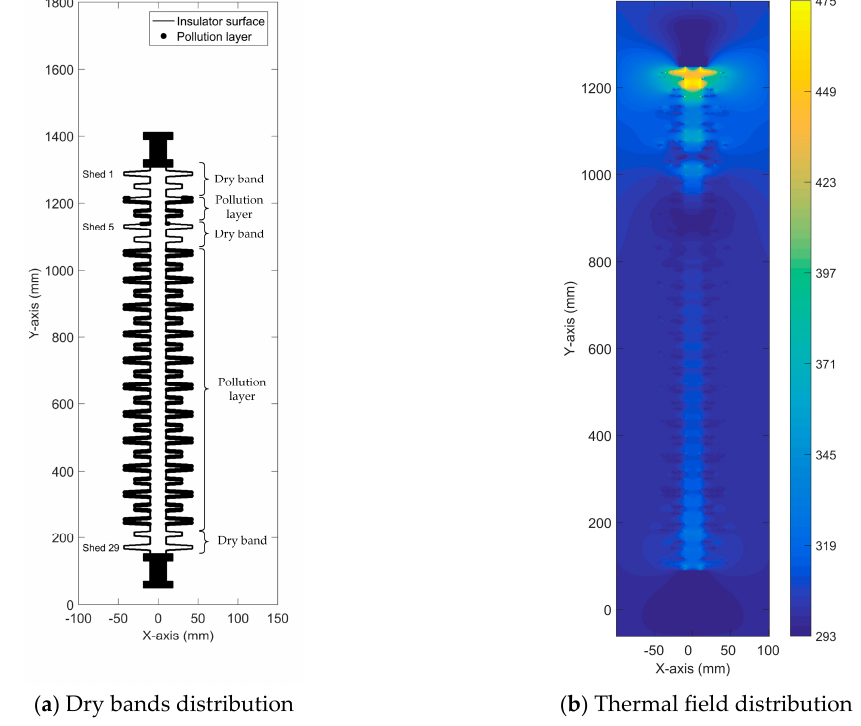
Figure 8. Dry bands and thermal field distributions close to the HV